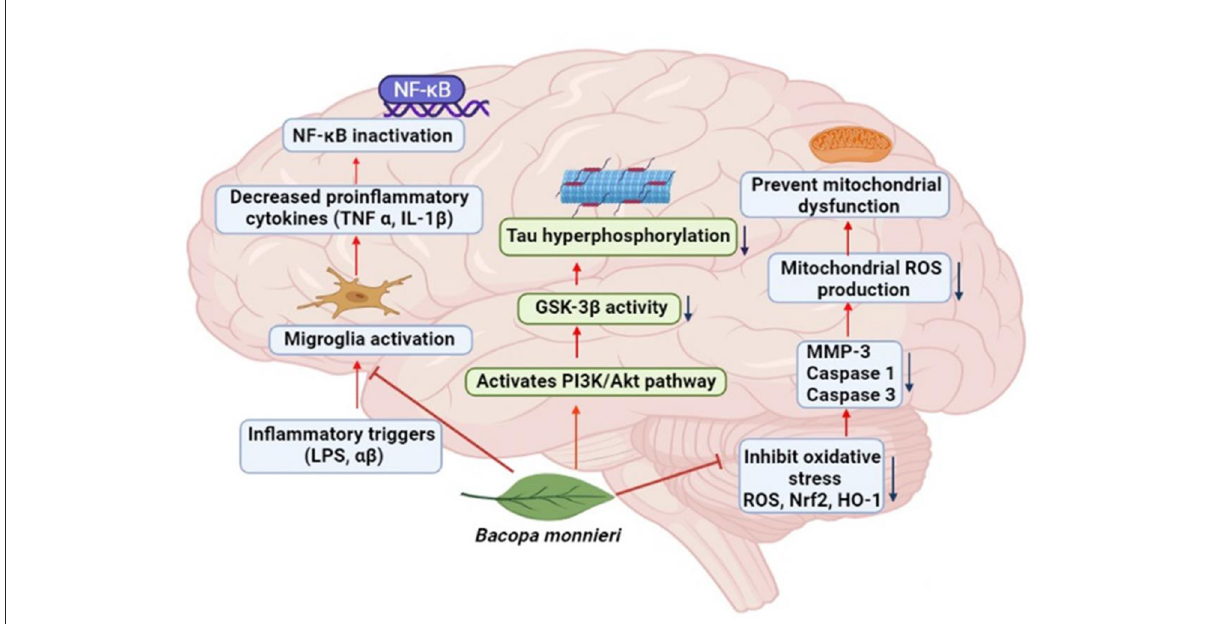
FIGURE3 The action mechanism of Bacopa monnieri against neurodegenerative